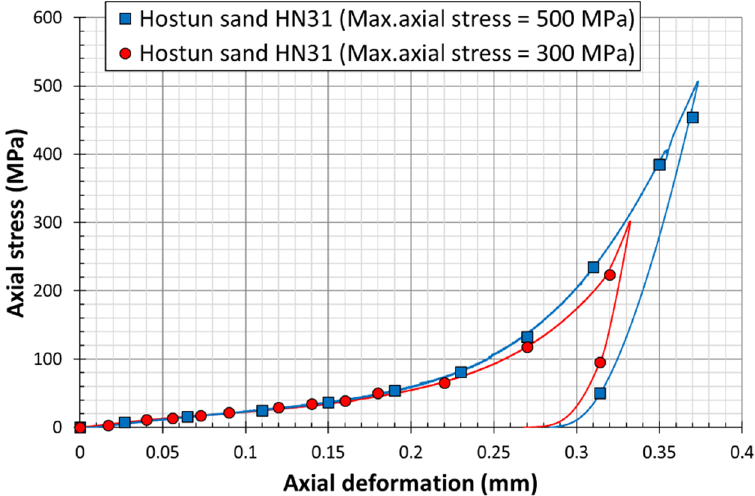
Figure 8. Quasi-oedometric test results conducted on Hostun sand grains (HN31) up to high axial stress levels of 500 MPa (bleu square dots) and 300 MPa (red circular dots).